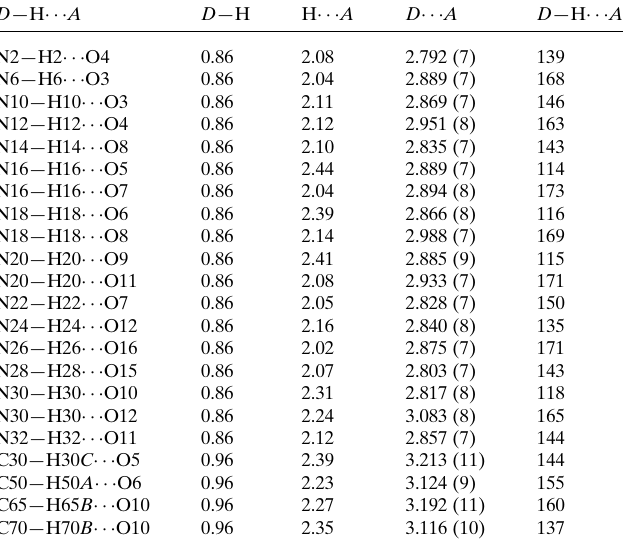
The spiral arrangement of the bridging oxygen atoms of the sulfate ligands, which bind [Cu(SO 4 )(Hdmpz) 4 ] formula units along the b -axis direction. Bridging oxygen atoms of sulfate ligands are represented as red spheres, while all other atoms are depicted as wireframes. Hydrogen atoms are omitted for clarity.